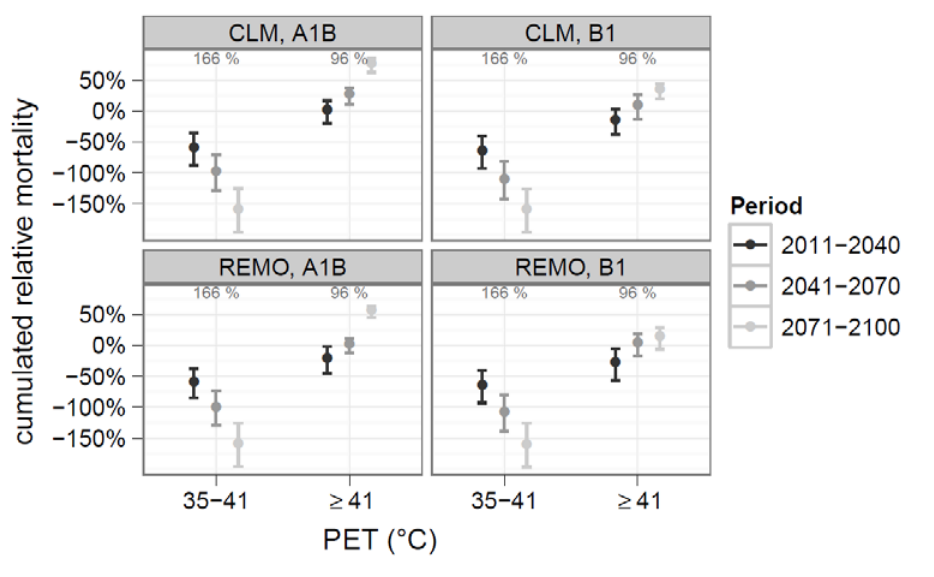
Figure 5. Changes in cumulated heat related mortality including long-term adaptation. The value of the period of examination is shown in gray in the upper margin of each panel. Days with moderate heat-stress were